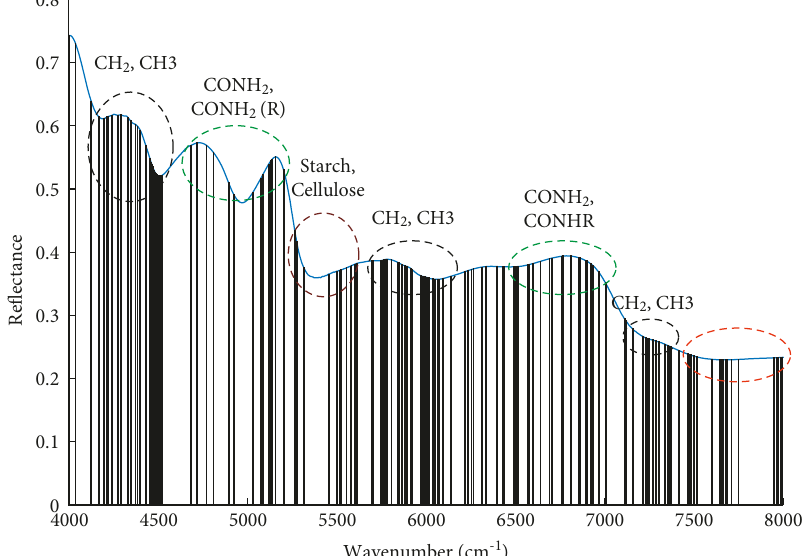
Figure 3: Results of variable selection obtained by the NSGA-II. The selected variables were mainly clustered in six chemically meaningful wavenumber bands and the band circled in red dashed lines was